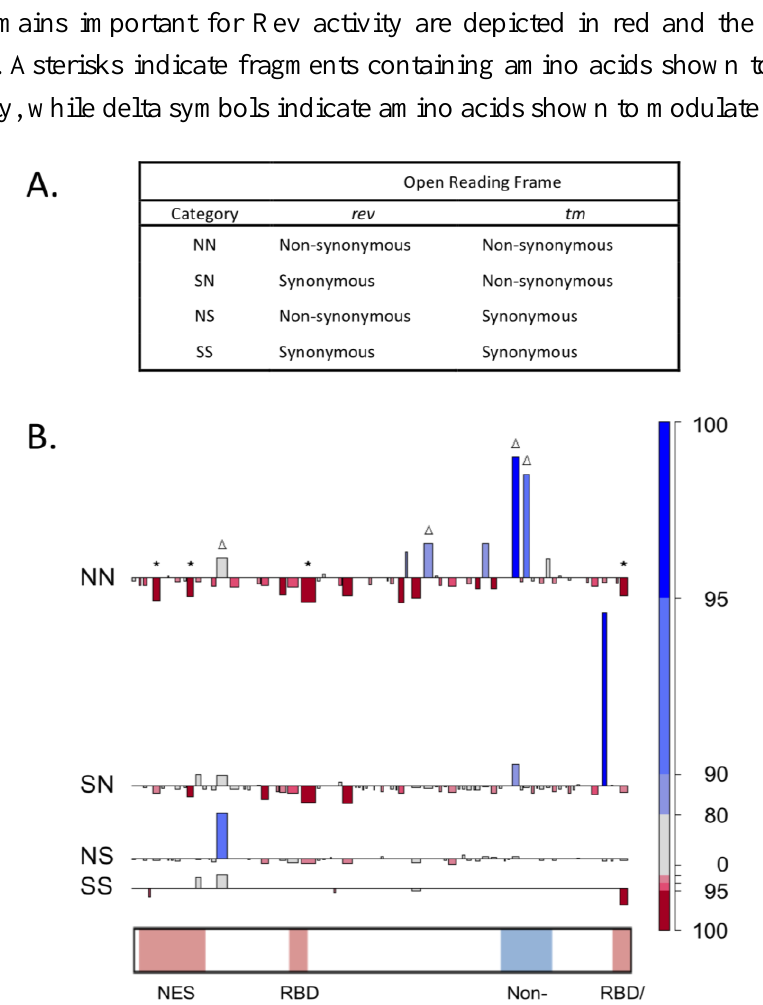
Figure 3. Analysis of mutations in rev/tm overlapping reading frames. ( A ) Categories of mutations in overlapping reading frames indicating the type of mutation in Rev and